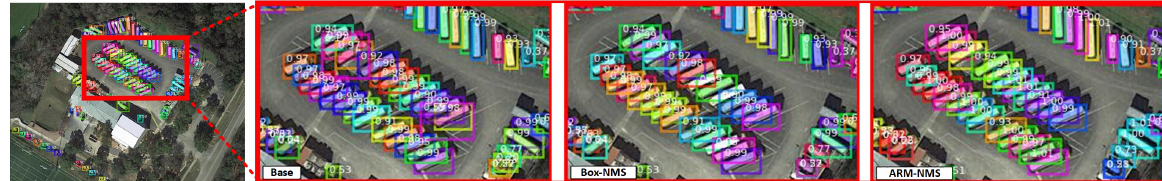
Figure 7. Visualization results on the iSaid: parking spot. The diagonally-aligned buses in the image section are a challenge for box-based NMS approaches. In contrast to ARM-NMS, Box-NMS eliminates true-positive detections due to overlapping boxes. overlap potential for bounding boxes. Image section one